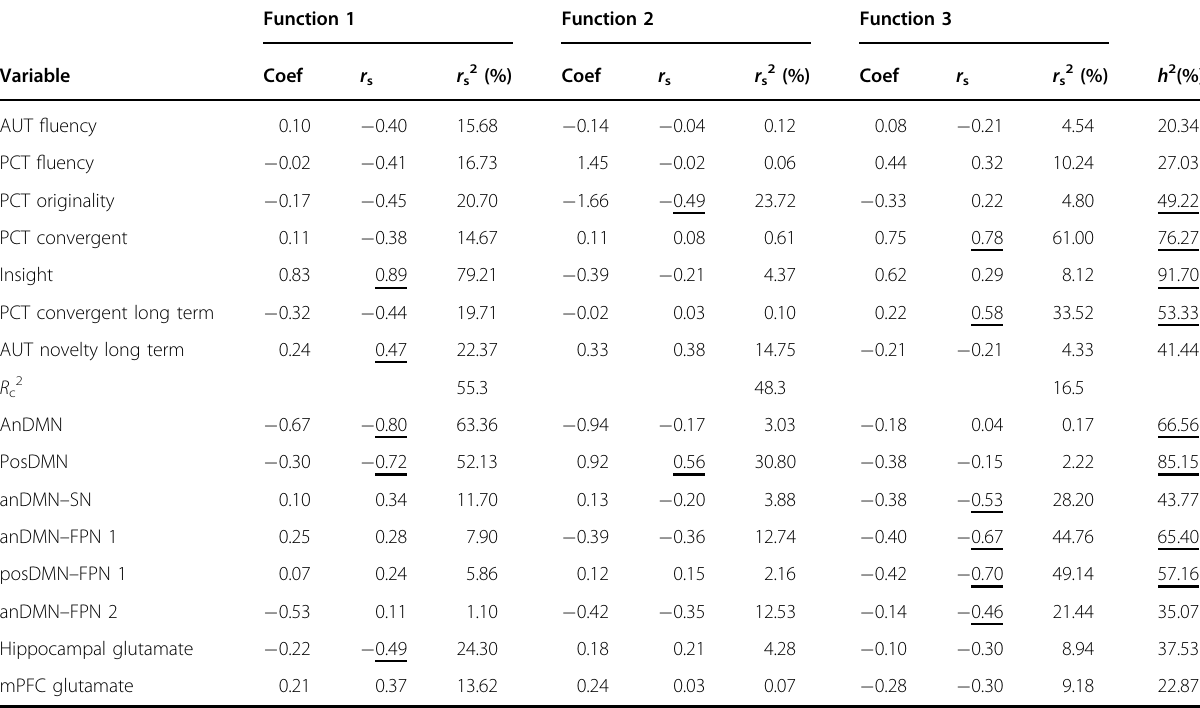
Table 2 Canonical solution for biological variables predicting creativity variables for all